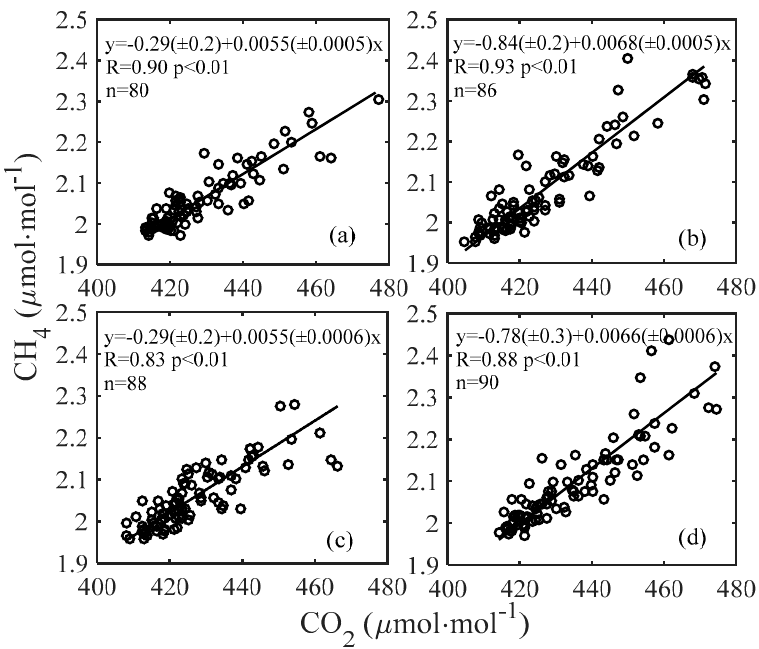
Figure 8. Scatter plots of winter (December–February) daytime CH 4 and CO 2 concentrations at MLW from 2012 to 2016. Each data point represents one daytime mean value. Regression statistics (regression equation, linear correlation R and number of samples) are also shown. Parameter ranges in the parentheses are 95% confidence bounds: ( a ) December 2012–February 2013; ( b ) December 2013–